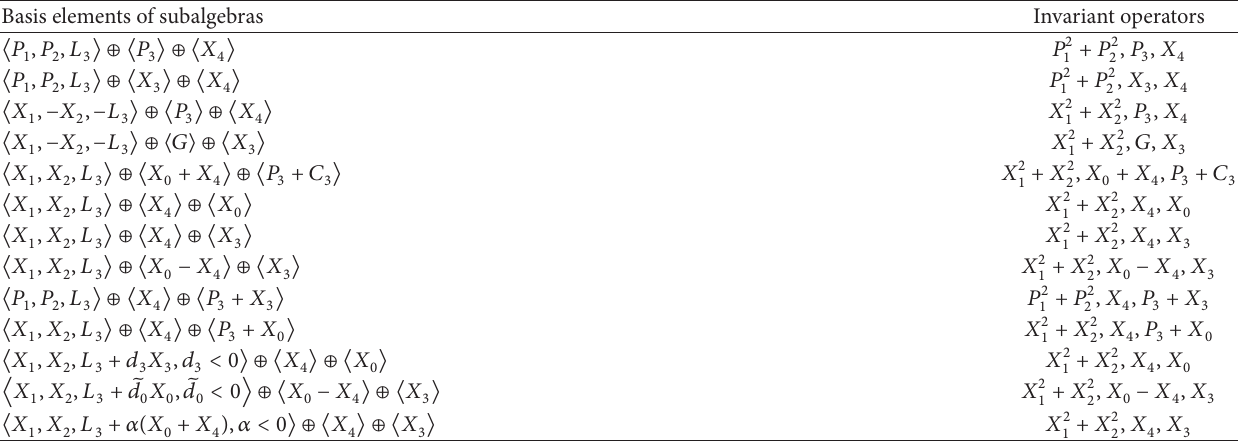
Table 5: Invariant operators of subalgebras of the type 𝐴 3,6 ⊕ 𝐴 1 ⊕ 𝐴 1 . Basis elements of subalgebras